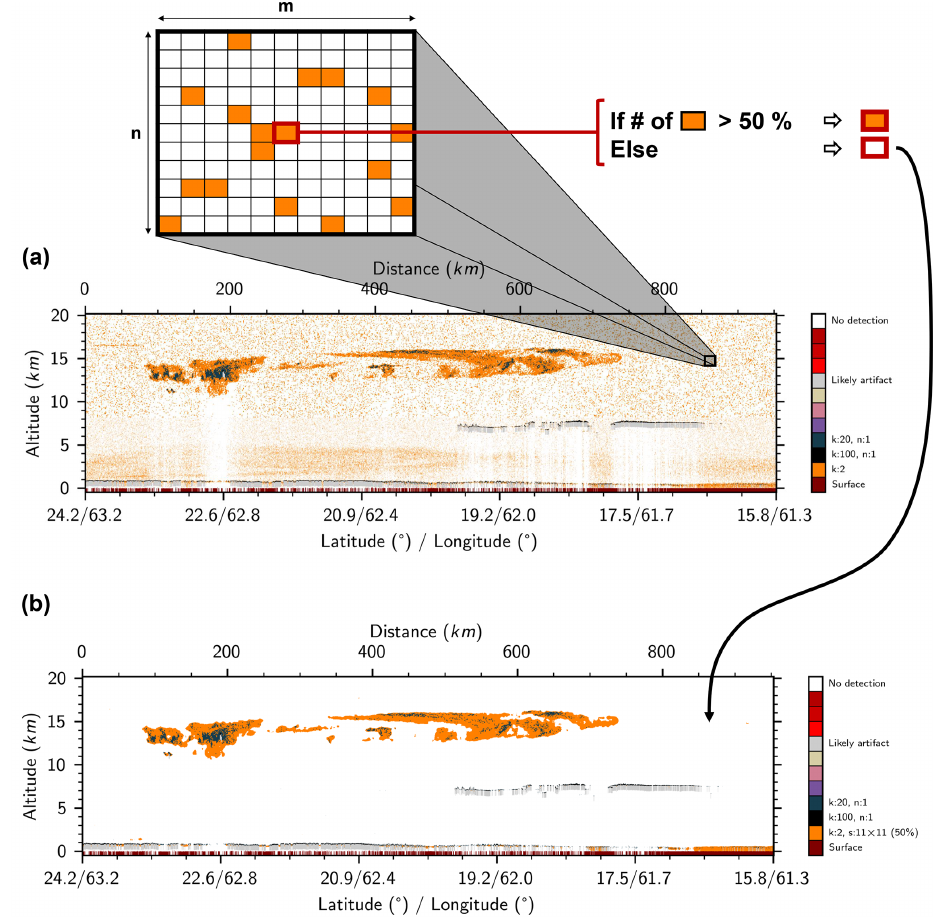
Figure 5. Illustration of the spatial coherence test window substep of 2D-McDA on the 532nm parallel channel for the case study shown in Fig. 1. (a) Pixels which are over the detection threshold given by Eq. (6) with the value of k = 2 (orange). (b) Result after applying a 11 × 11 spatial coherence test window on the detected pixels. Note that the insert at the top is just an illustration and does not show the real content of the image